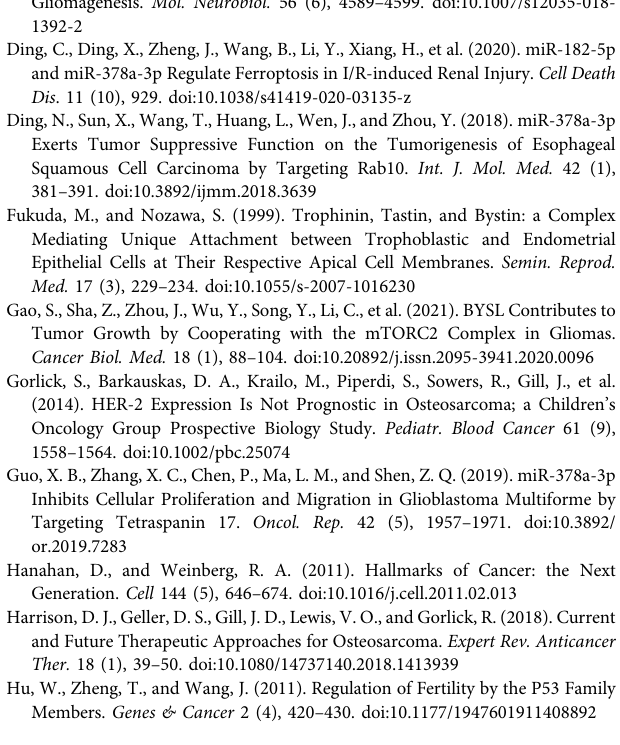
Supplementary Figure S3 | BYSL, E-cadherin, N-cadherin, and vimentin in MG63 and Saos-2 were examined using western blot. * p < 0.05. Supplementary Figure S4 | Bax, Bcl2, E-cadherin, N-cadherin, and vimentin, BYSL, and Nrf2 were examined using western blot under normoxia. * p < 0.05. Supplementary Figure S5 | Bax, Bcl2, E-cadherin, N-cadherin, and vimentin, BYSL, and Nrf2 were examined using western blot under hypoxia. * p < 0.05. Supplementary Figure S6 | Overall survival was compared between osteosarcoma patients with high and low miR-378a-3p expression in TCGA